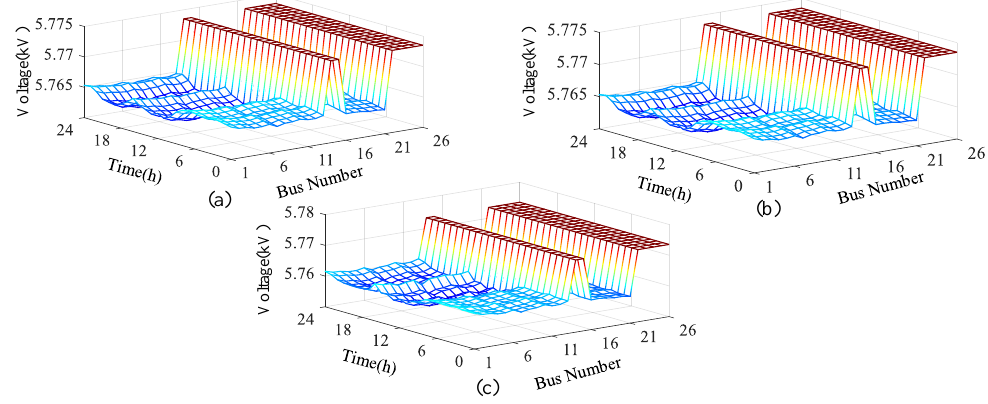
Figure 9. Voltage in different scenarios: ( a ) Scenario 1 ( b ) Scenario 2 ( c ) Scenario 3. The voltage and current of each bus at 20 h are shown in Figure 10. The voltage amplitude increases toward the value of the rated voltage, and the current amplitude is smaller than the corresponding value in Scenario 1. The voltage and current quality of the network with ESSs have been significantly improved, which not only help improve the accommodation ability of the network, but also verify the practicability of the proposed two-layer optimization model.